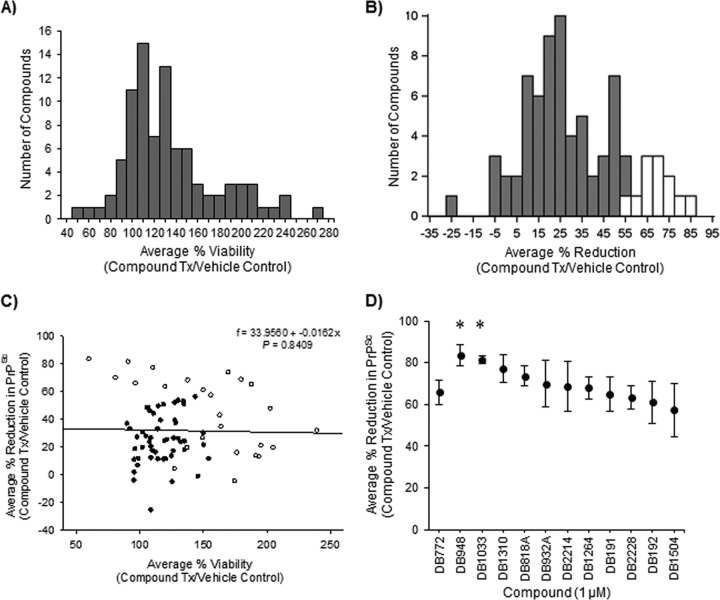
Identification of DB compounds inhibitory at 1 μM in PrPSc-positive hTERT-ovine microglia. Following 4 days of incubation with 1 μM (each) DB compound, cell viability and PrPSc inhibition were evaluated by WST-1 assay and SSCA, respectively. Values were expressed as the percent change in viability or PrPSc spot number versus the vehicle control (0.1% DMSO). (A) Distribution of tested compounds with regard to effects on cell viability. Values along the x axis represent the mean percent viability from a minimum of three independent experiments. Values along the y axis represent a number of the total compound population that falls within a value of percent change. Compounds were compared to the vehicle control, and those lacking significant effects on cell viability or of distinct structural interest were selected for inhibition screening. (B) Distribution of selected compounds with regard to effects on PrPSc accumulation. Values along the x axis represent the mean percent change in spot number from a minimum of three independent experiments. Values along the y axis represent the number of the total compound population that falls within a value of percent change. Compounds with a percent reduction of greater than or equal to 68% (+ standard deviation) were identified as preliminary hits and selected for further testing (white bars). (C) Correlation between average percent reduction in PrPSc and average percent viability following 1 μM treatment with DB compounds with (open circles, PDun < 0.05) or without (closed circles) significant effects on cell viability. The black line represents the best fit line following linear regression analysis. (D) Average percent reduction in PrPSc by the 12 preliminary hits selected from panel B. Values were statistically compared to that of the reference molecule, DB772, to determine enhanced inhibitory activity (*, PDun < 0.05). Error bars represent ±1 standard deviation of the mean from at least 3 independent experiments.